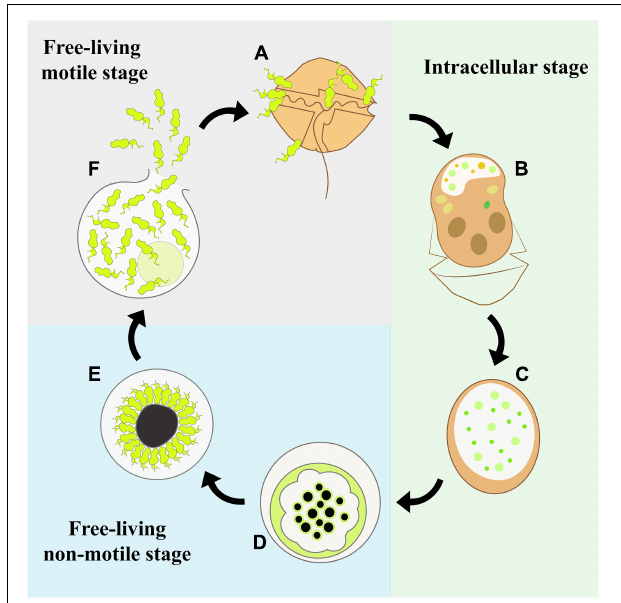
FIGURE 9 | Diagram of the life-cycle stages of Maranthos nigrum . (A) A dinoflagellate cell is infected by free-living, motile zoospores. (B) Within this infected host cell, the parasitoid develops its life cycle starting from the feeding stage, when the host cytoplasm is consumed and an early trophont develops. The infected cell loses its theca and commonly acquires an elongated shape. (C) A late trophont has consumed all of the host cytoplasm. (D) It then develops into a free-living, non-motile sporont and replication to form new zoospores begins. (E) The zoospores develop inside the sporont, showing a radial disposition at the periphery of the cell outer membrane around a large central blackish body, which is distinctive of this species. (F) Once the zoospores are mature, the outer membrane ruptures and the zoospores are released into the environment.